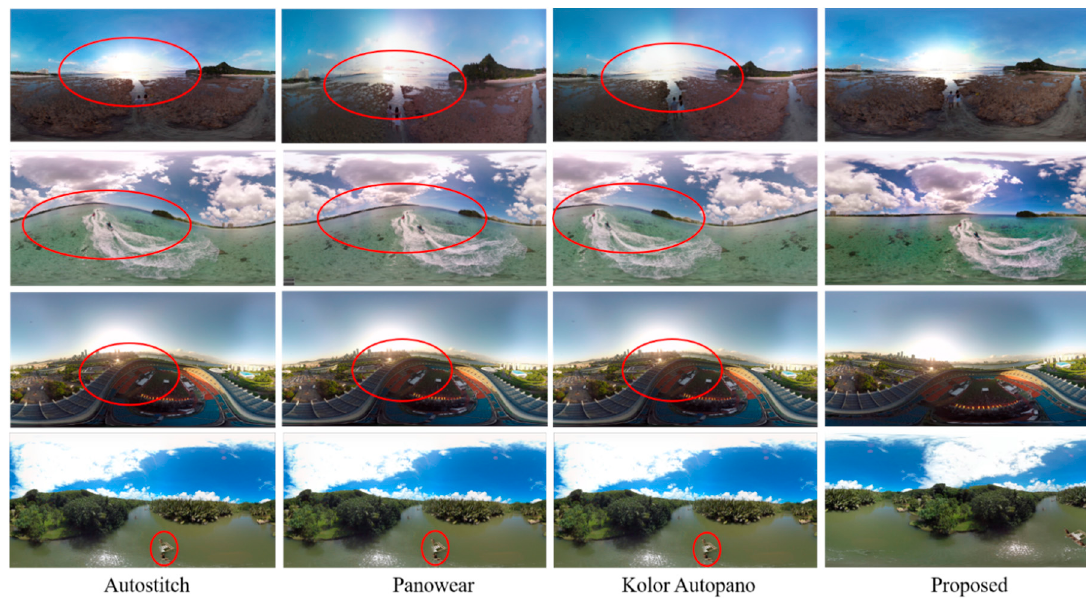
Figure 7. Visual comparison of panoramas generated by our proposed system with existing manual panorama generation systems.